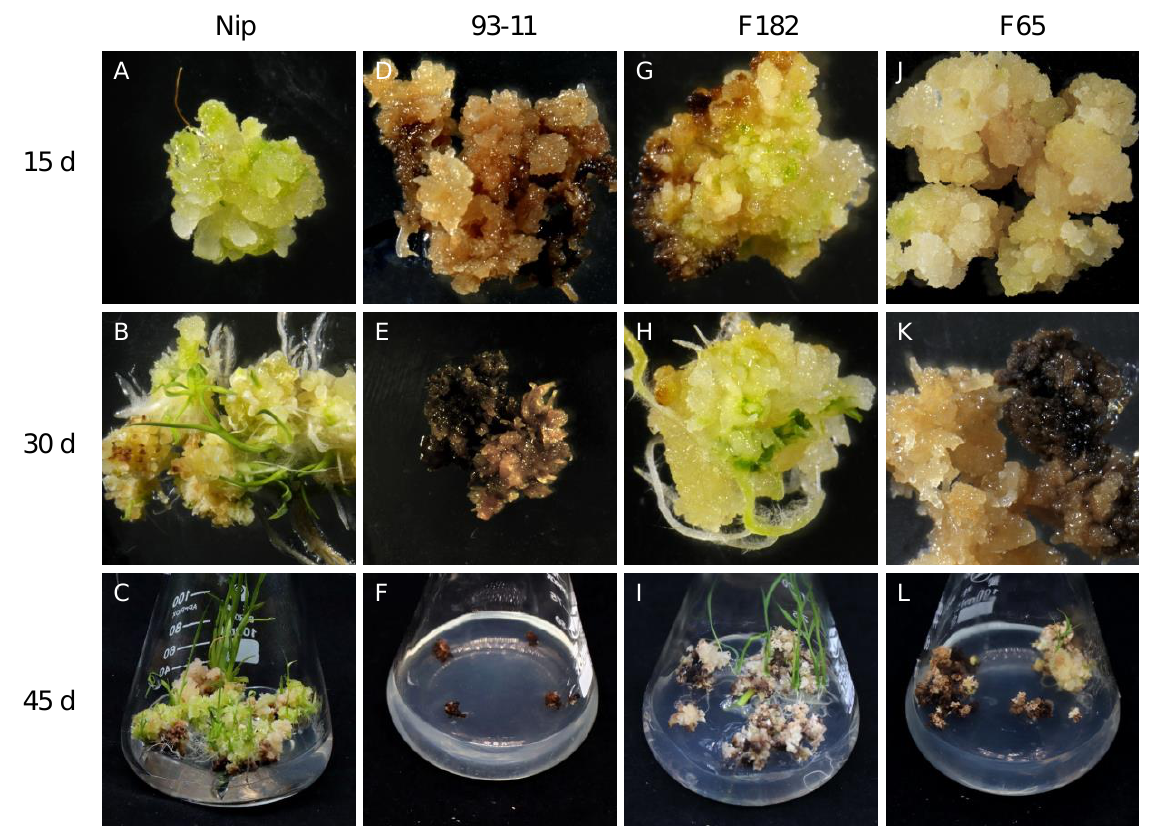
Figure 1. Regeneration of typical RIL. Regeneration of embryogenic callus from parental Nip and 93-11, and RIL of easy-to-regenerate F182 family and difficult-to-regenerate F65 family. ( A , D , G , J ): at 15 d, Nip produced many green spots; 93-11 began to brown; F182 regenerated green spots and began to brown; and F65 only had a few green spots. ( B , E , H , K ): at 30 d, Nip produced regenerated plantlets; 93-11 were browned and died; F182 regenerated shoots; and F65 was half-browned and half-vitrified. ( C , F , I , L ): after 45 d, Nip produced many regenerated plantlets; 93-11 died; F182 produced a few weak regenerated plantlets; and there were no regenerated plantlets for F65.